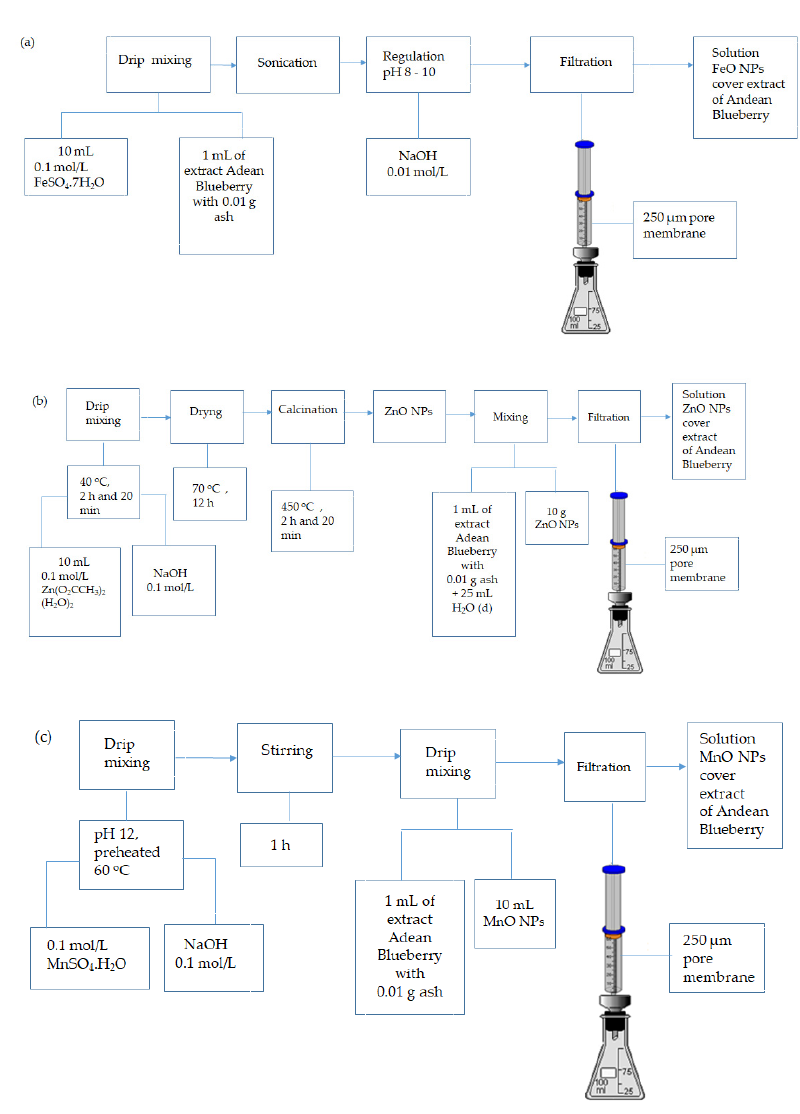
Figure 2. The process diagram for the synthesis of ( a ) FeO, ( b ) ZnO, and ( c ) MgO NPs.